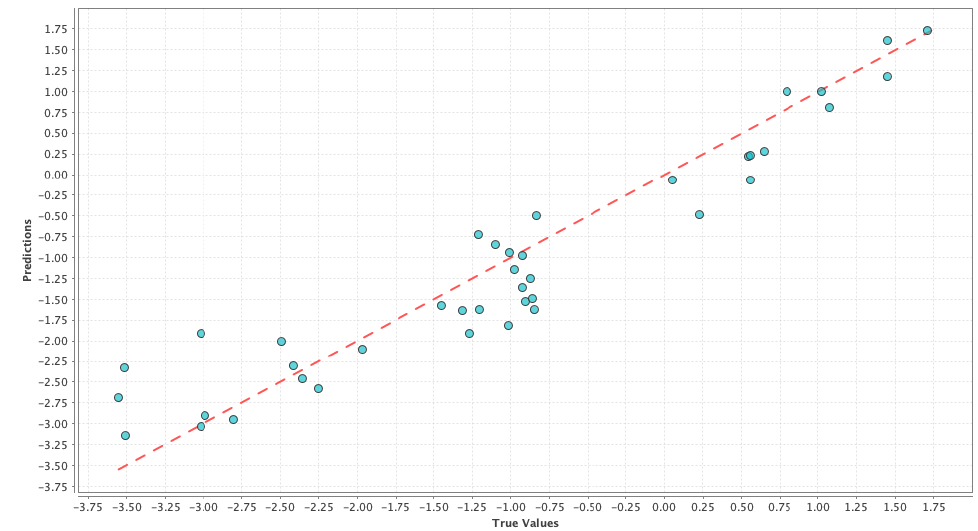
Figure 8. Result on Test Set For Support Vector Machine using Model 10 from Table 3. The x-axis represents the true or the actual PDSI values and the y-axis represents the predicted PDSI values. Each small blue circle in the figures is represented by the tuple ( PDSI actual , PDSI pred ). The red dashed line is the reference line to test the model performance.